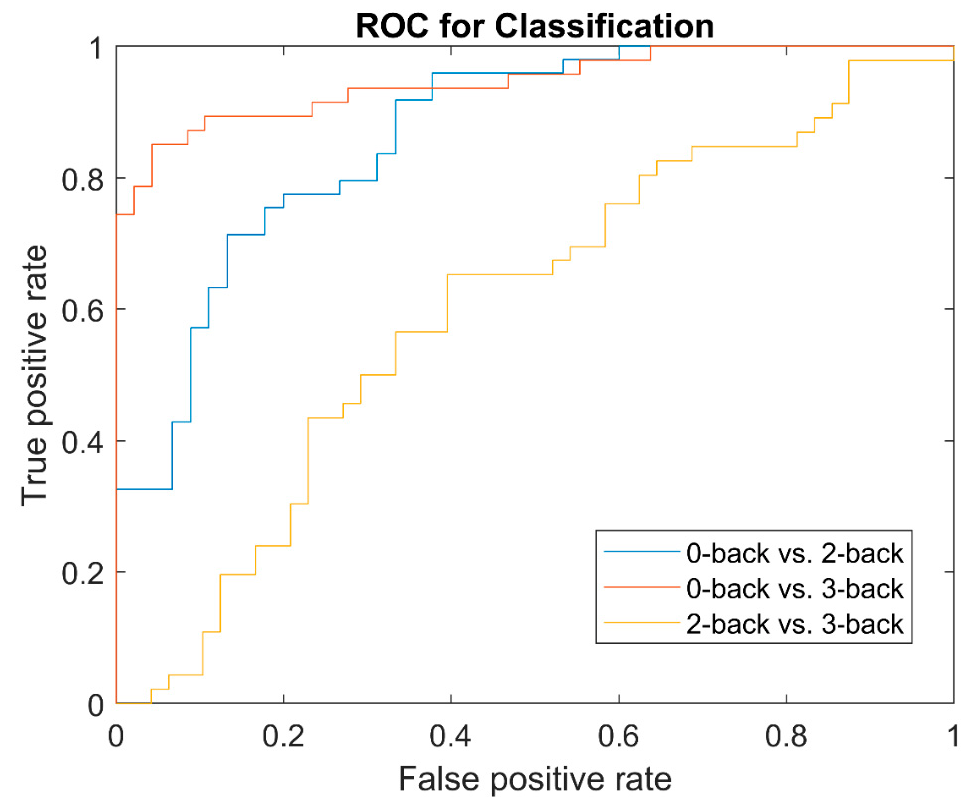
Figure 5. The receiver operating characteristic (ROC) curves for three binary classification tasks: 0 ‐ back vs. 2 ‐ back, 0 ‐ back vs. 3 ‐ back, and 2 ‐ back vs. 3 ‐ back.